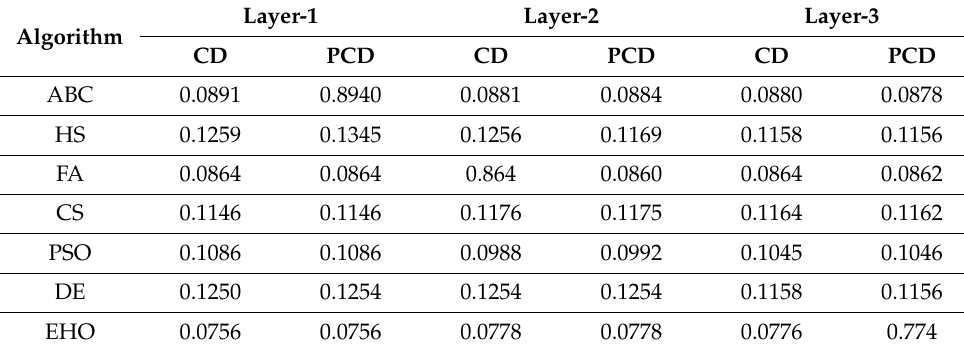
Table 4. Average MSE over the LAG dataset.